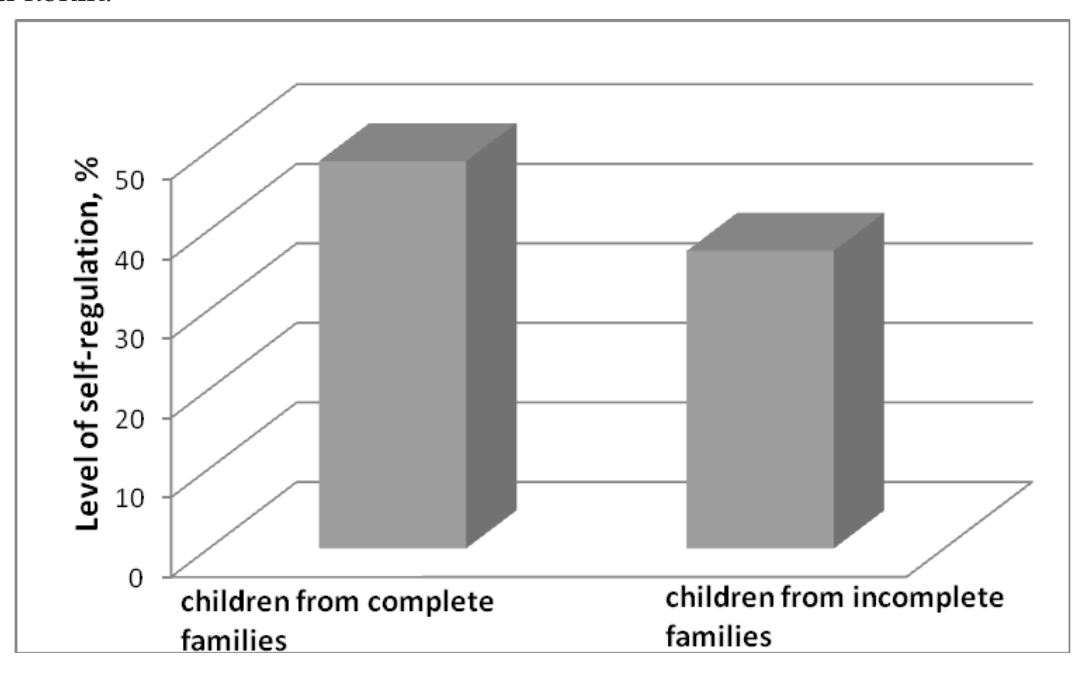
Fig. 4. Differences in the level of self-regulation in children with nuclear and single parent families according to method “Graphic dictation” by Daniil